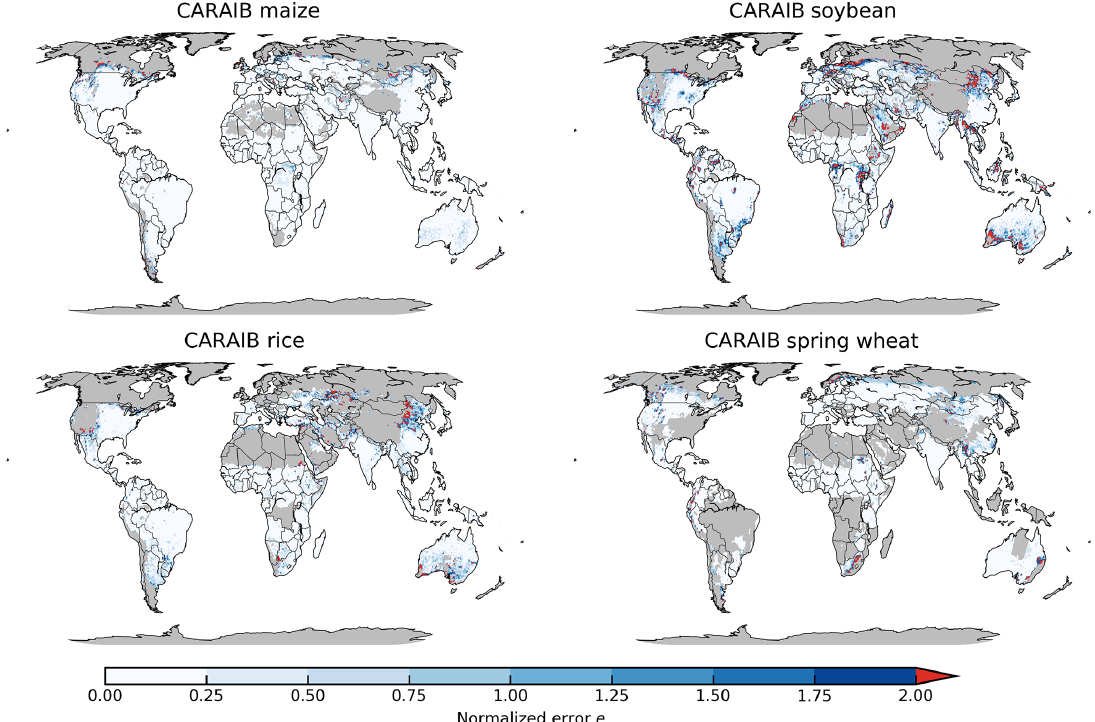
Figure 8. Illustration of our first test of emulator performance, applied to the CARAIB model for the T + 4 scenario for rainfed crops. Colors indicate the normalized emulator error e , where e > 1 means that emulator error exceeds the multi-model standard deviation. For consistency, we show e only for geographic areas simulated by at least six models and where baseline yields are greater than 0.5tha − 1 . Emulator performance is generally good relative to model spread in areas where crops are currently cultivated (compare to Figs. S2–S3) and in temperate zones in general; emulation issues occur primarily in marginal areas with low-yield